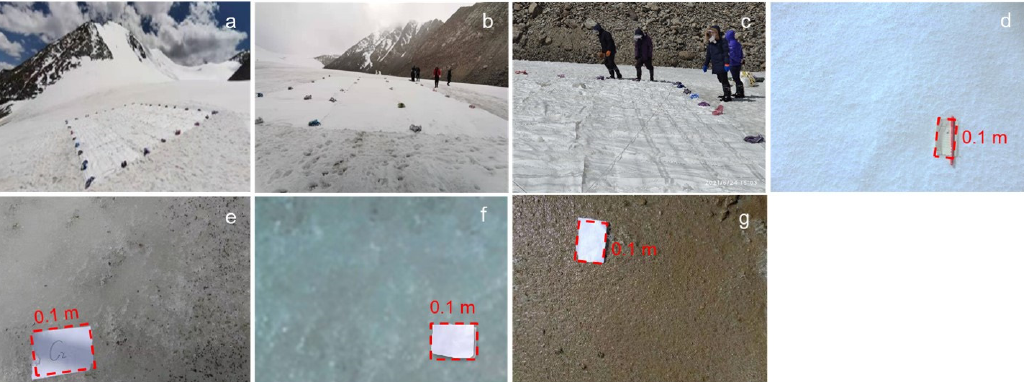
Figure 9. Images of the surface of UG1 and measured albedo ( α ) values. ( a – g ) represent the nanofiber material, geotextile with an area of 150 m 2 , geotextile with an area of 200 m 2 , clean snow, dirty snow, clean ice, and dirty ice, respectively.